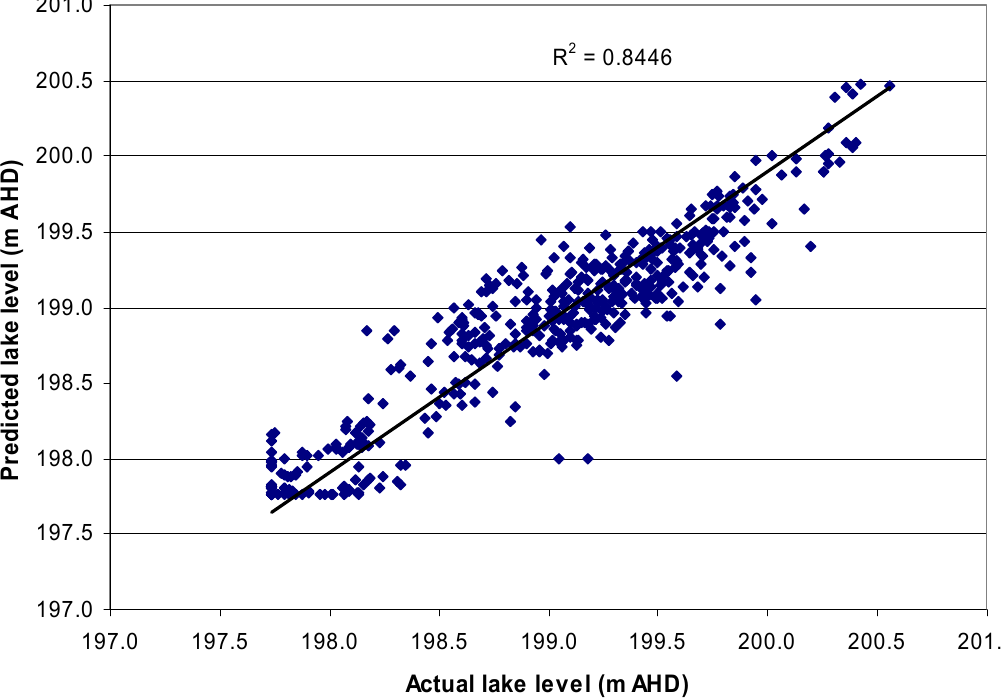
Figure 11. Lake Linlithgow measured water levels and a comparison to modeled results for the period 1964–2007.